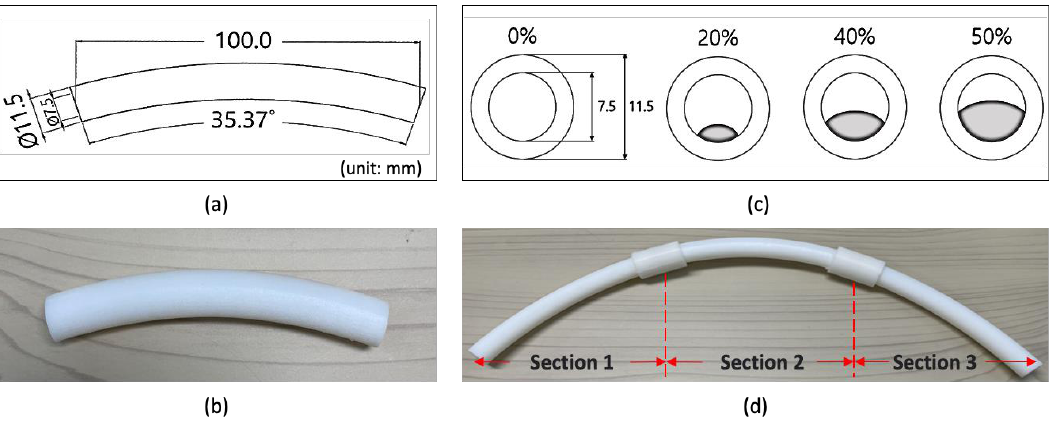
Figure 3. Artificial ET tube that simulates each location and degree of obstruction. ( a ) Artificial ET tube drawing; ( b ) 10 cm artificial ET tube, three according to the degree of obstruction and control (20% to 50%), three according to the location of obstruction (Sections 1 to 3), for a total of 12 pieces; ( c ) cross-Sections for degree of obstruction (20%, 40%, and 50%); and ( d ) an artificial ET tube consisting of three interconnected tubes.